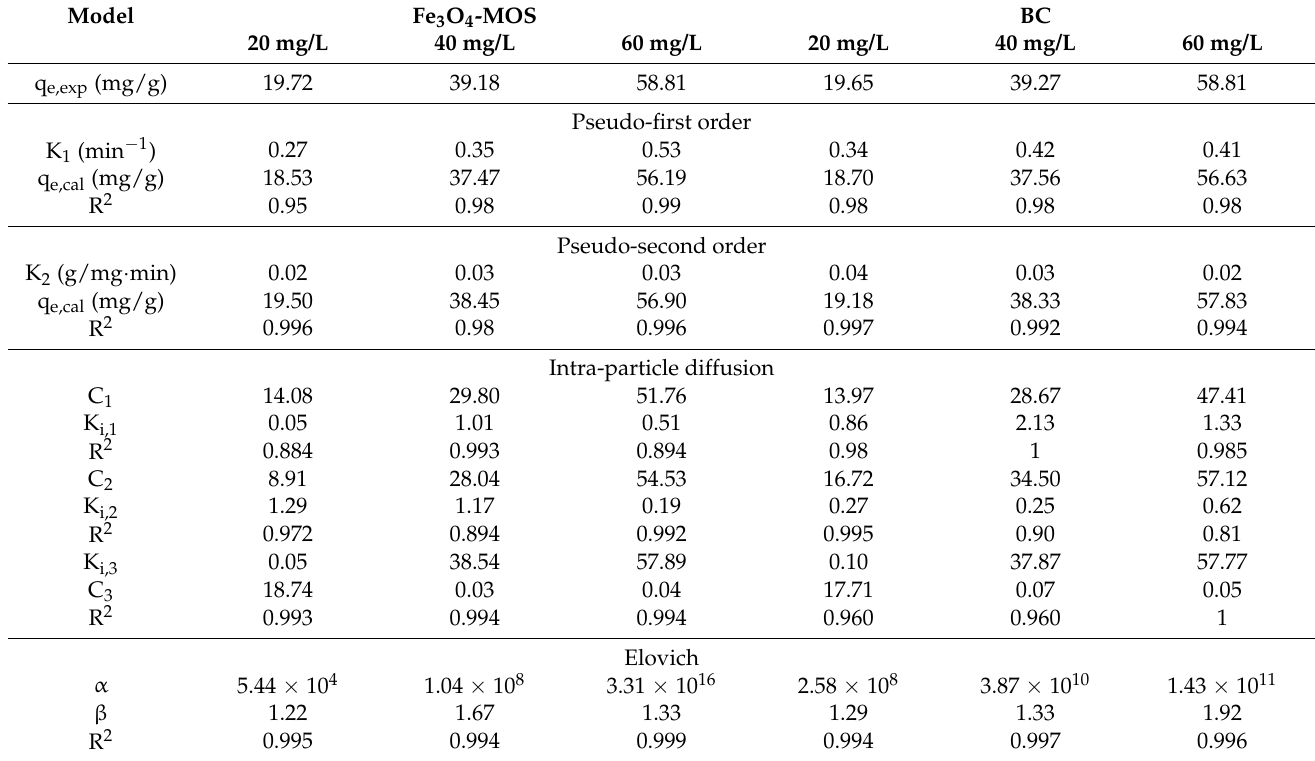
Table 1. Kinetic parameters of PFO model, PSO model, Elovich model and IPD